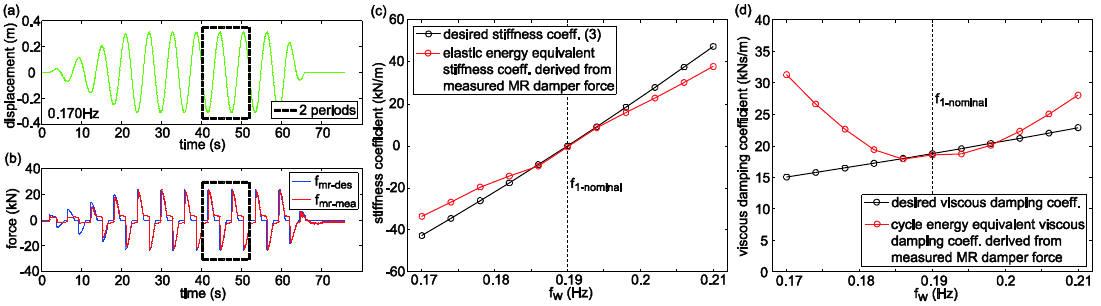
F = 0 N in control F = 0 N in control 0 0